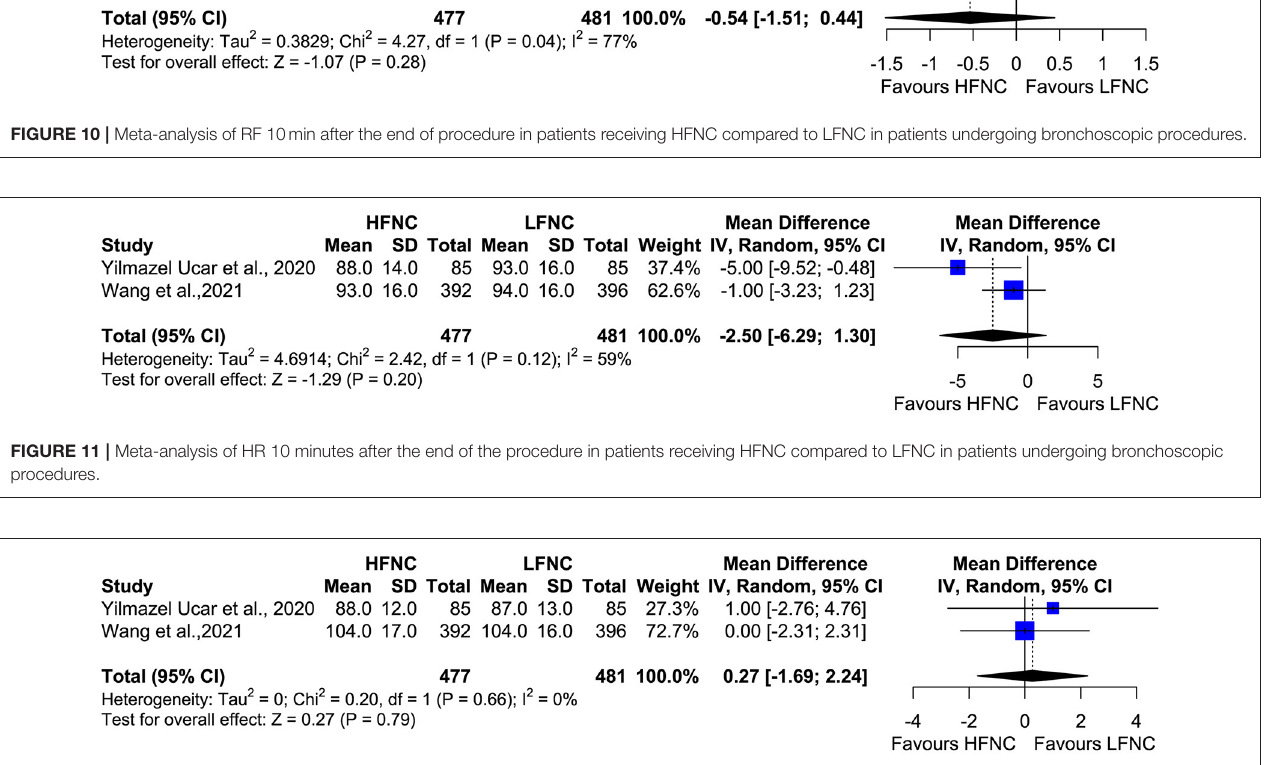
FIGURE 12 | Meta-analysis of MAP 10min after the end of procedure in patients receiving HFNC compared to LFNC in patients undergoing bronchoscopic